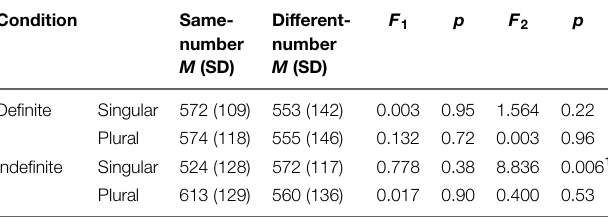
TABLE 2 | Experiment 1 reaction time (RT) analyses.